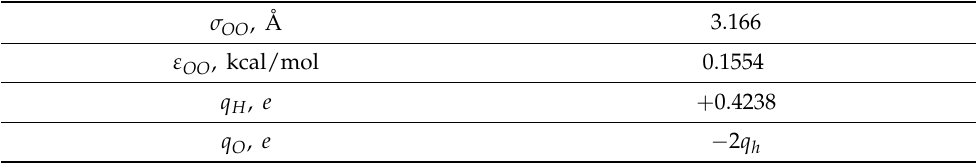
Table 1. Parameter values for SPC/E water model.